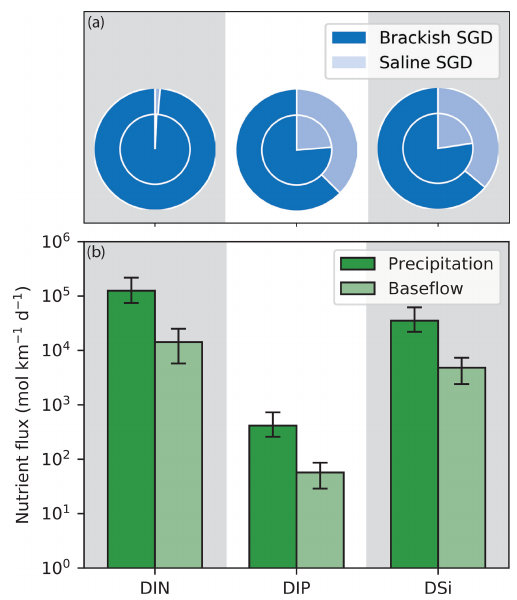
Figure 5. SGD-derived nutrient fluxes of dissolved inorganic ni- trogen (DIN), dissolved inorganic phosphorus (DIP), and dissolved silicate (DSi) at Maresme County. Panel (a) shows the relative con- tribution of brackish (dark blue) and saline (light blue) SGD dur- ing EPE (inner pie chart) and in baseflow conditions (outer pie chart). Panel (b) represents the median nutrient fluxes at Maresme County during the EPE of October 2019 (P1) and in baseflow con- ditions (BF) (fluxes normalized by the coastline length). Error bars indicate the interquartile range (25% and 75%